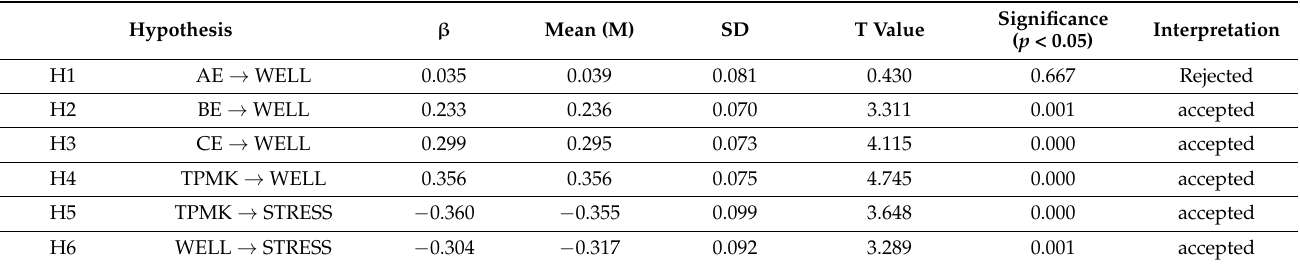
Table 6. Results of initial hypothesis testing.